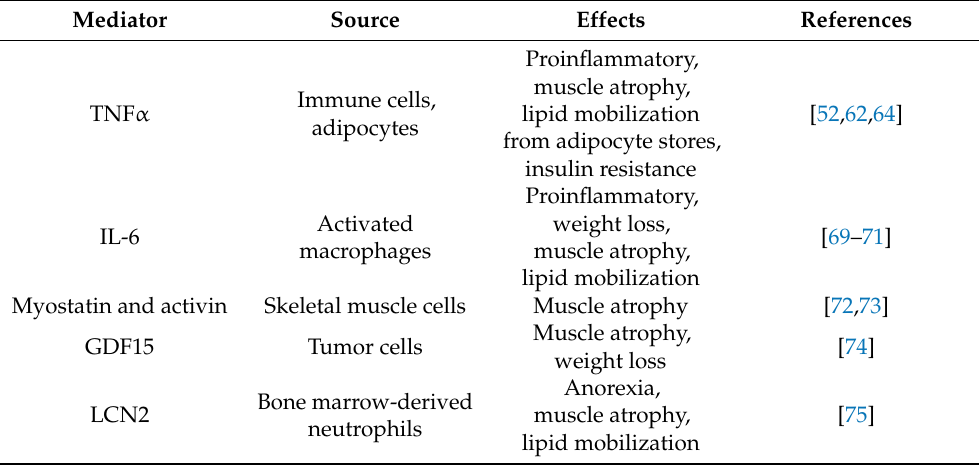
Table 1. Summary of other mediators involved in the onset of cancer cachexia beyond TGF- β